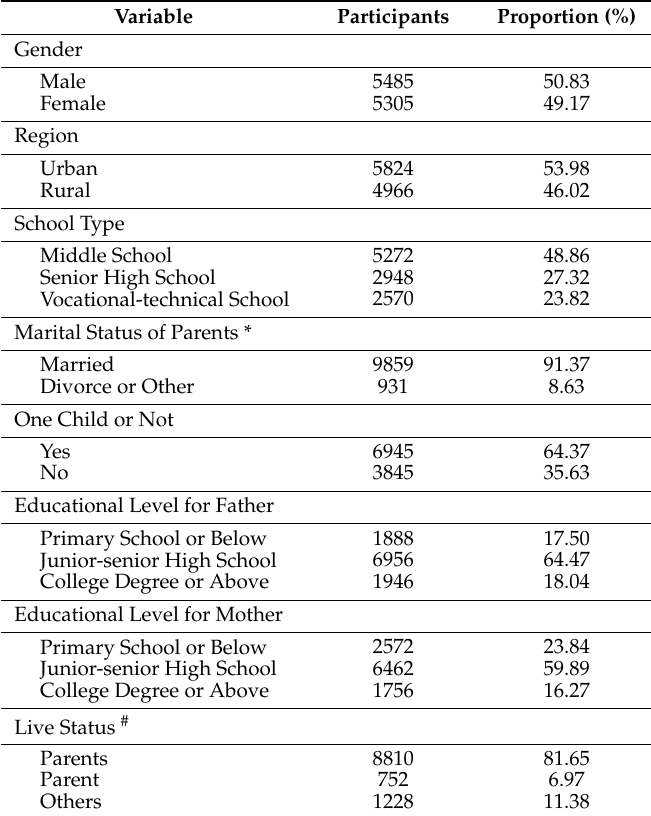
Table 1. General characteristics of the study